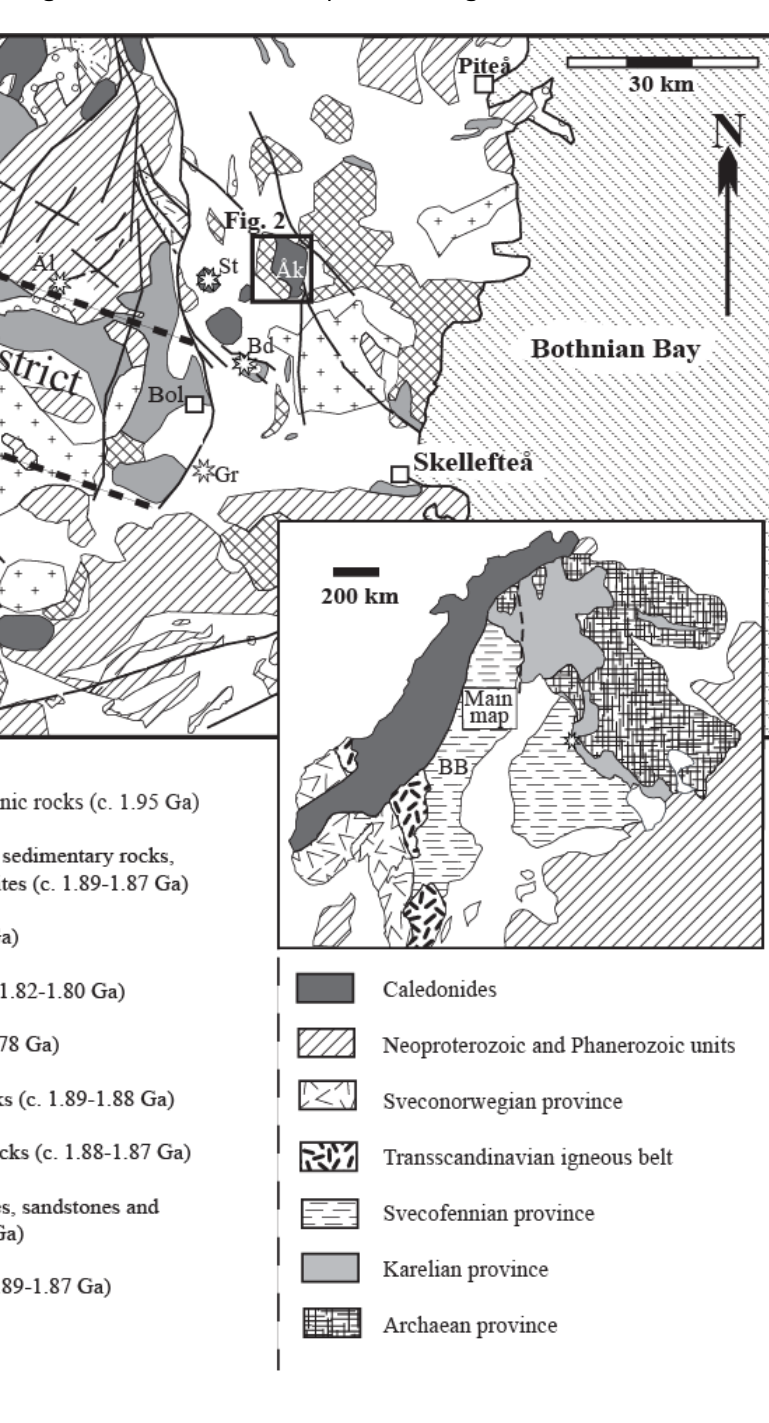
Figure 1. Geology of the Skellefte district; inset map = Fennoscandia. Added to the map are symbols for gold and VMS occurrences (Äl = Älgträsk, Bd = Björkdal, Bol = Boliden, Gr = Grundfors, Sk = Skäggträskberget, St = Storklinten; note that certain of the mineralizations mentioned in the text fall outside the map area. Dotted lines outline the SE part of the Lycksele-Storuman ore district (LSOD); whereas the stippled lines indicate the extension of the Skellefte massive ore-bearing district. Abbreviations in inset map: BB = Bothnian basin. The rectangular box shows the map area of Figure